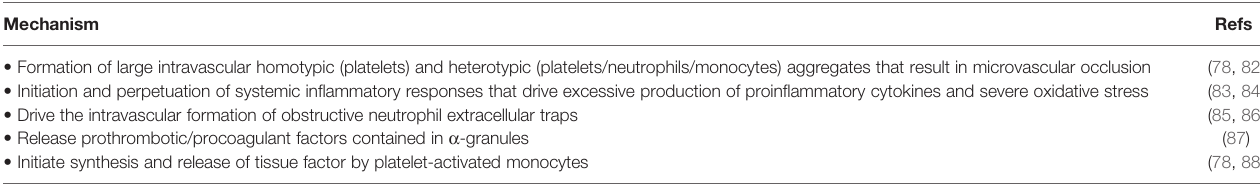
TABLE 3 | Mechanisms by which activated platelets contribute to vascular and organ damage during severe COVID-19 infection.